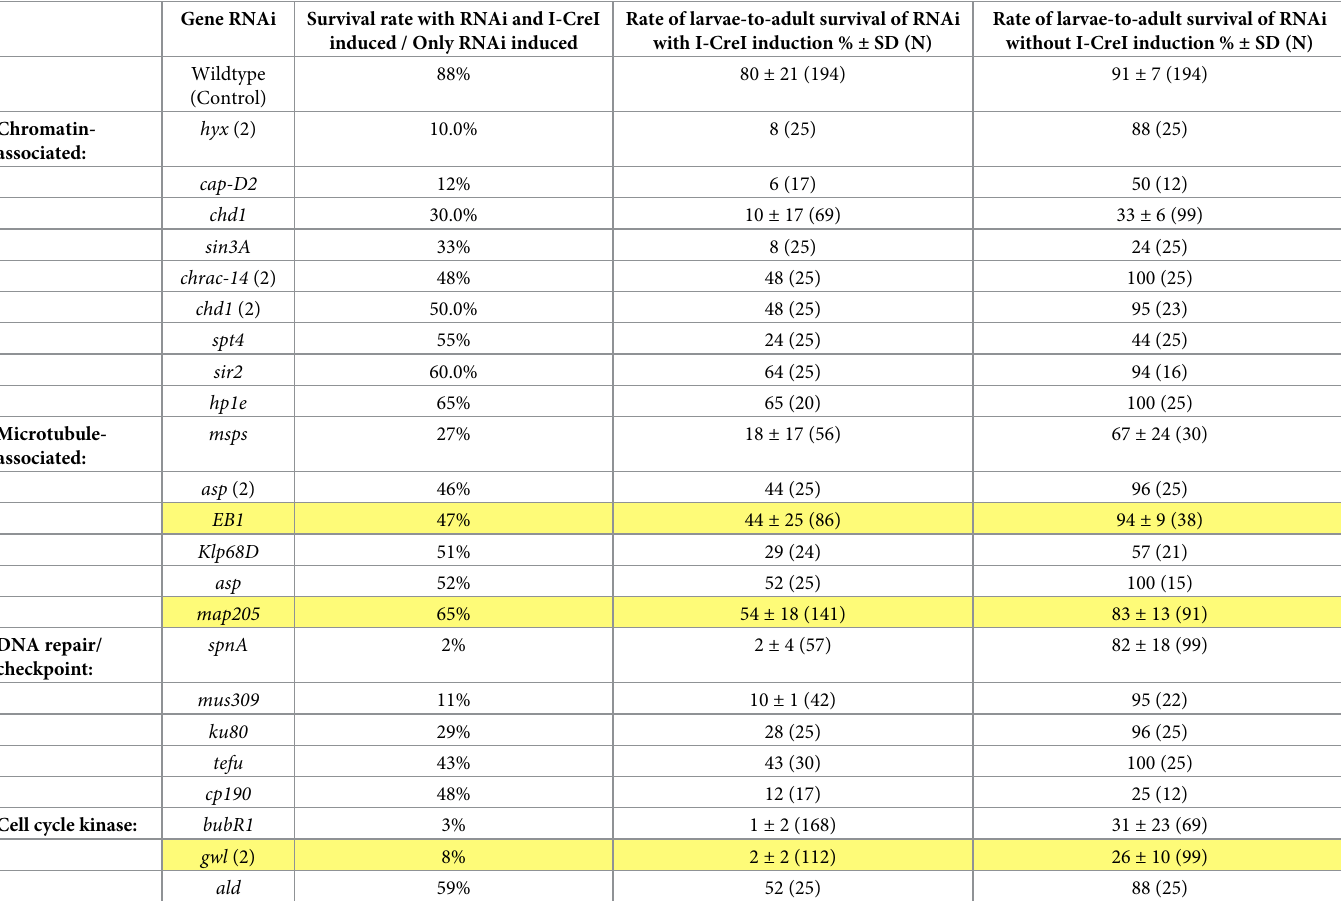
Table 1. Top hits from synthetic lethality screen. Top hits from the synthetic lethality screen were grouped by gene function. Overall survival rate ratio was determined by the following: (percentage of surviving larvae after RNAi and I-CreI induction) / (percentage of surviving larvae after only RNAi induction). Those RNAi transgenes that resulted in significant reduction in survival (a ratio of less than 0.65) were considered for follow-up live analysis. Gene